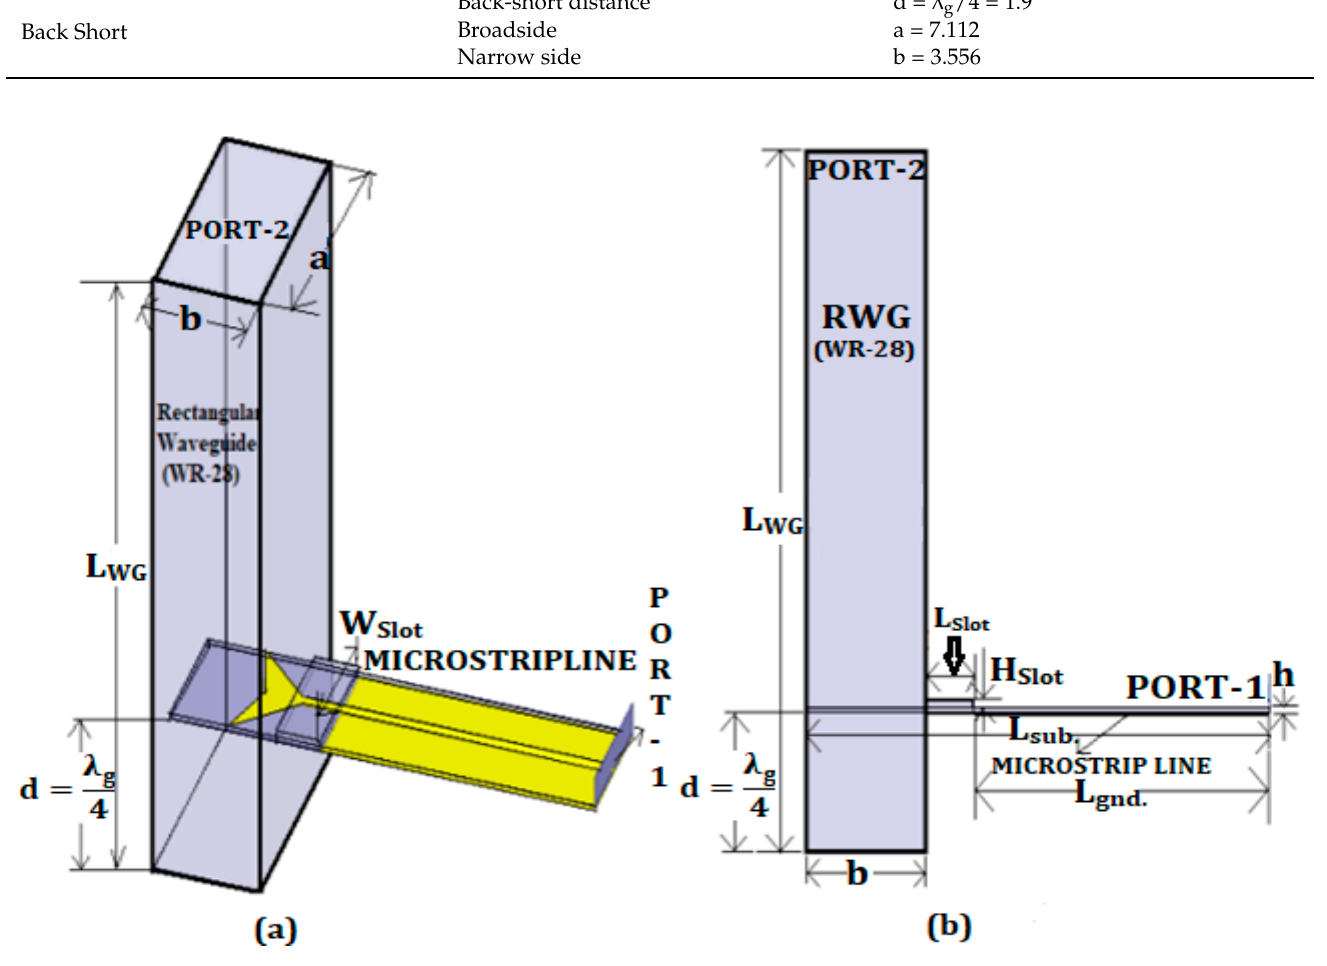
Figure 1. ( a ) Rectangular − waveguide to fishtail-shaped microstrip line transition at 30 GHz. ( b ) Side view of the rectangular waveguide to fish-tail-shaped microstrip line transition at 30 GHz.